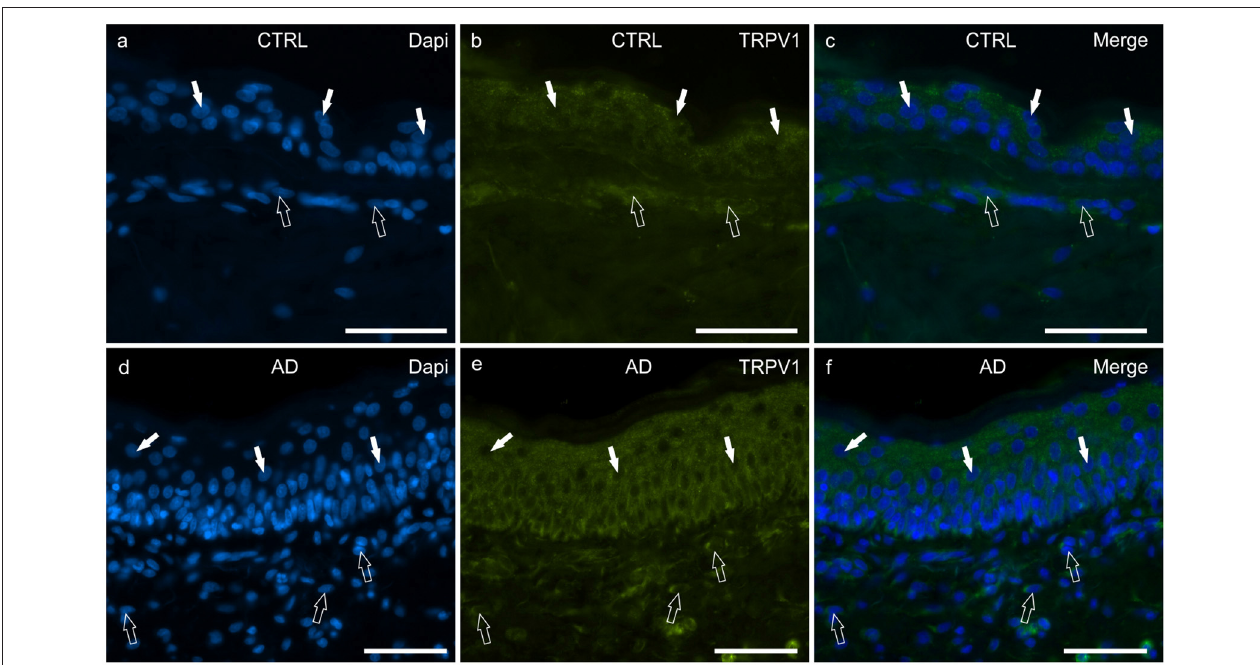
FIGURE 5 | Photomicrographs of cryosections of canine skin showing transient receptor potential vanilloid 1 (TRPV1) immunoreactivity (IR) in the tissues of the healthy dogs (CTRL) (a–c) and in the dogs with atopic dermatitis (AD) (d–f) . (a–c) The white arrows indicate some DAPI-labeled nuclei of the keratinocytes of the CTRL dogs showing moderate cytoplasmic TRPV1-IR. The open arrows indicate some DAPI-labeled nuclei of the dermal cells showing moderate TRPV1-IR. (d–f) The white arrows indicate some DAPI-labeled nuclei of the keratinocytes of the AD dogs showing bright cytoplasmic TRPV1-IR. The open arrows indicate some DAPI-labeled nuclei of the dermal cells showing bright TRPV1-IR. Bar, 50 µ